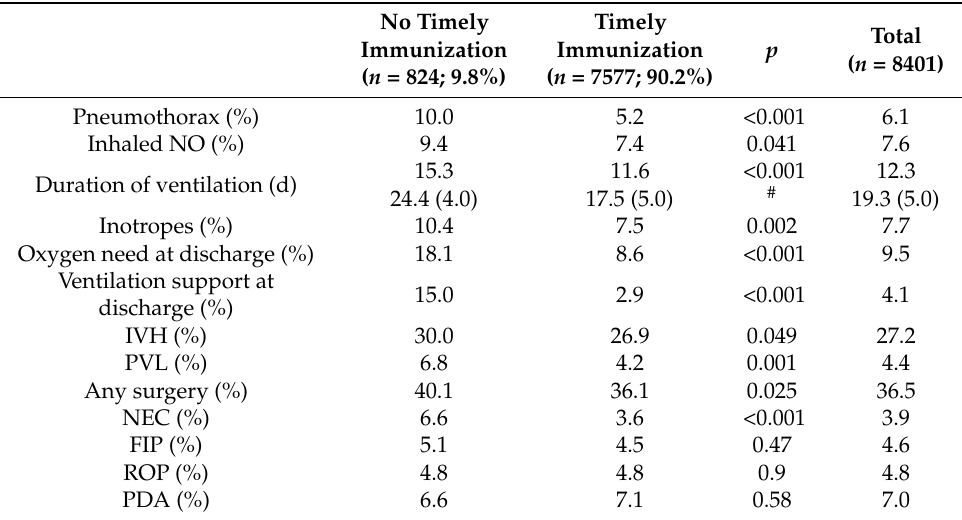
Table 2. Treatment and outcome parameters stratified to timely pneumococcal and hexavalent